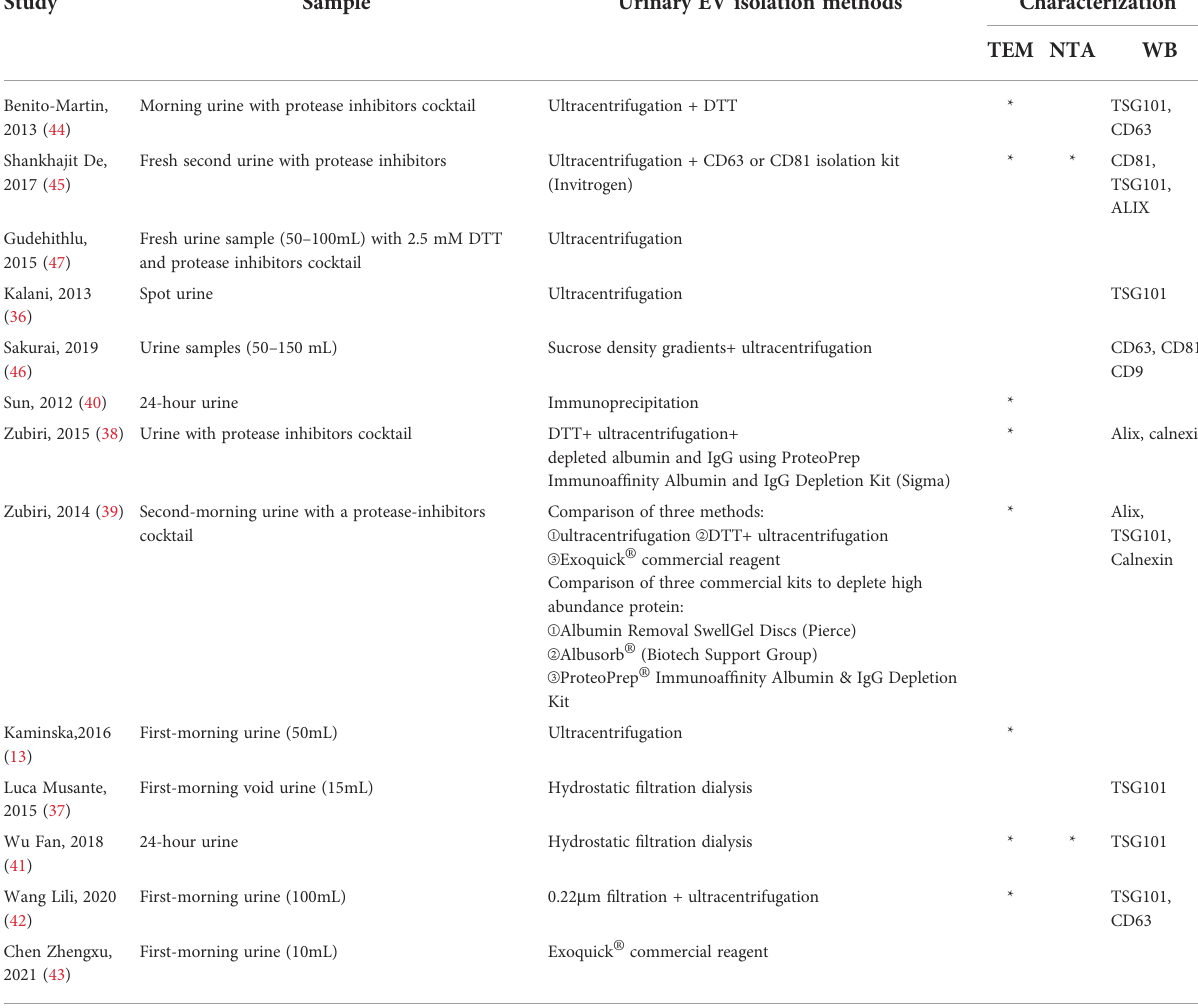
TABLE 3 Methodology of urinary exosome extraction and characterization in eligible